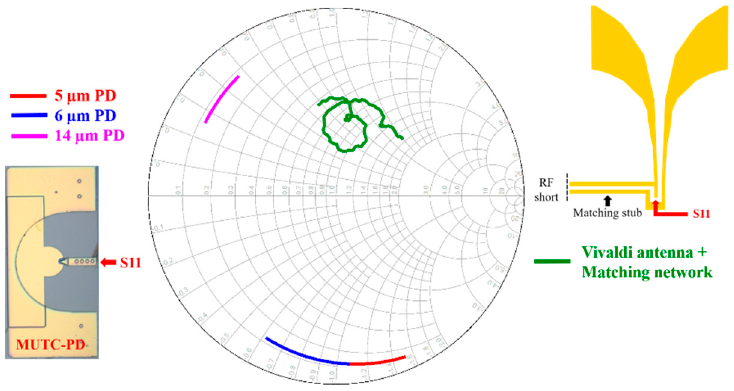
Figure 8. Scattering parameters of 5-, 6-, and 14- µ m-diameter PDs and the Vivaldi antenna with a matching network.